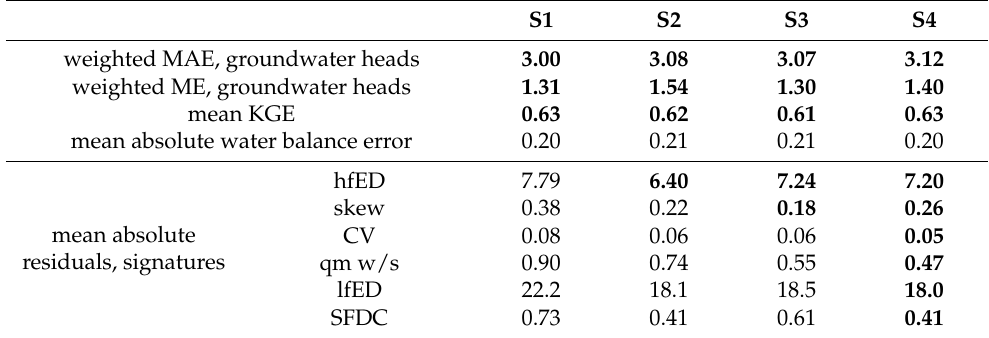
Table 4. Model performance after calibrating the four different scenarios. Criteria that were part of the respective objective function of each scenario are marked in bold (compare Table